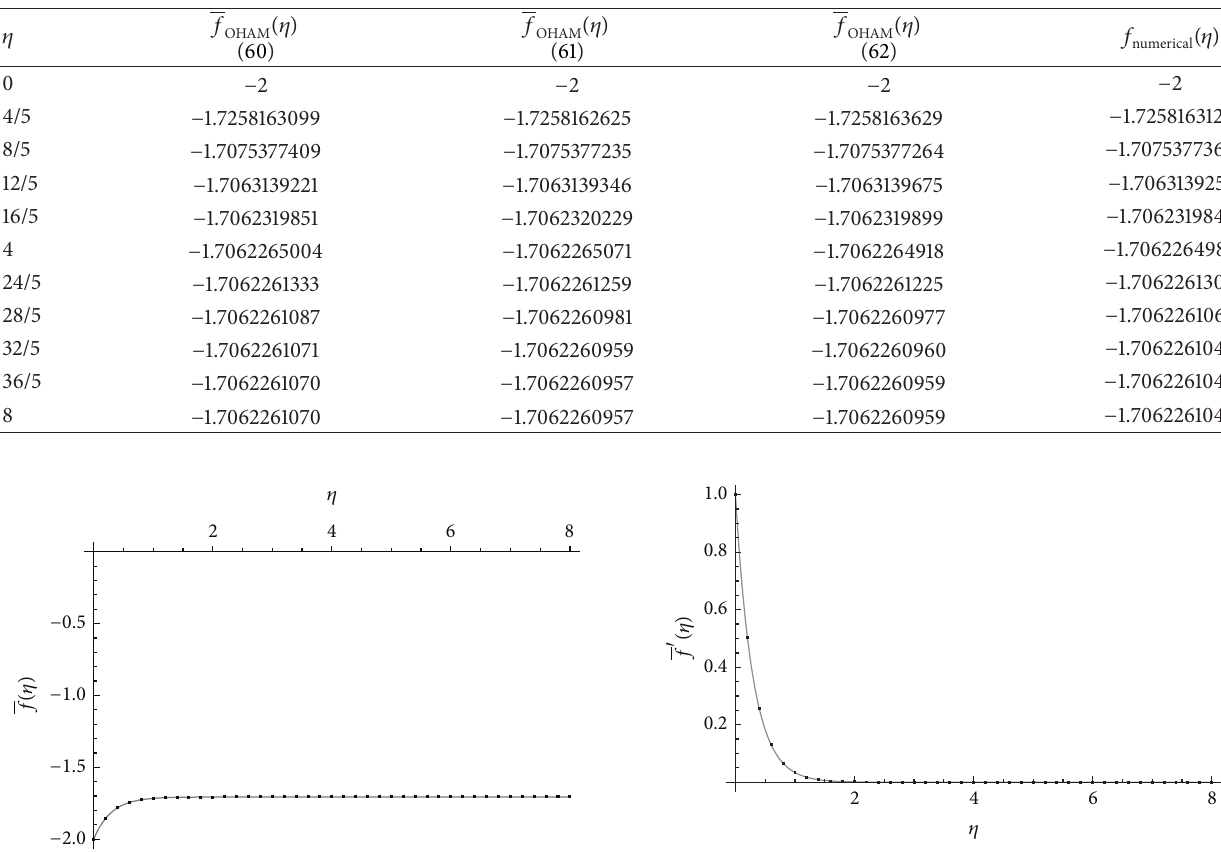
Figure 3: Comparison between the approximate solution (60) and numerical solution in the following cases: 𝛽 = 0.5 , 𝑀 = 0.75 , and 𝑅 = −2 —numerical solution; ......... approximate solution. have the constant variance and possible to control the analytic approximate solutions for any real interval.